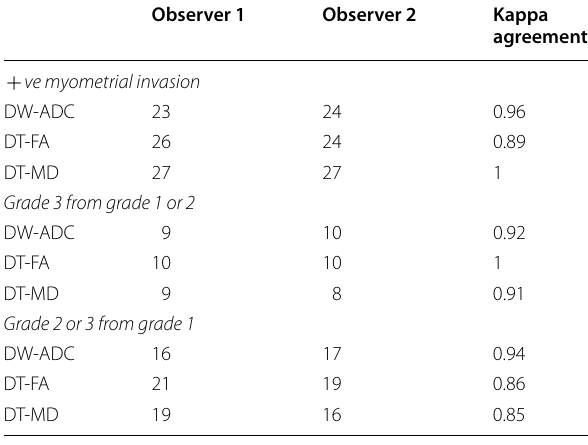
Table 8 The inter‑observer correlation coefficient between both observers as regard DW‑ADC, DT‑FA and DT‑MD in differentiating myometrial invasion and grading of